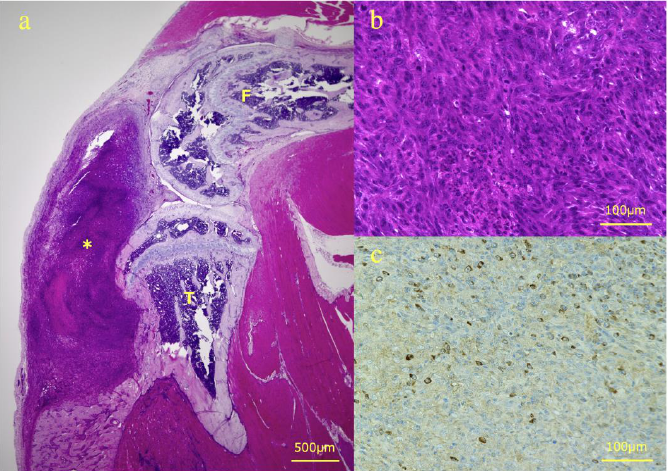
Figure 4. Representative findings of H-E staining and immunostaining. ( a ) H-E staining of a sagittal slice of the right lower limb. AT in the tibia is extending extraosseous (F: femur, T: tibia, *: AT). ( b ) HPF of the AT tissue with H-E staining. ( c ) HPF of AT tissue of the No. 3 sample in the CA group with CD8 immunostaining. Brown-stained cells are positive. HPF, high-power field; AT, abscopal tumor.